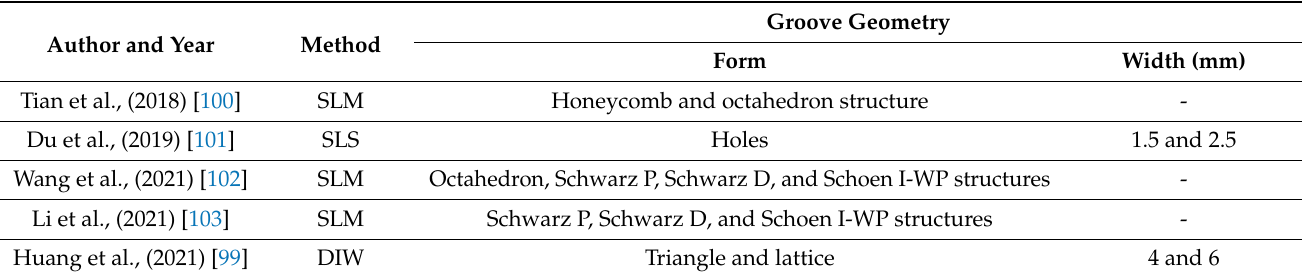
Table 8. Three-dimensional printing methods and geometries.